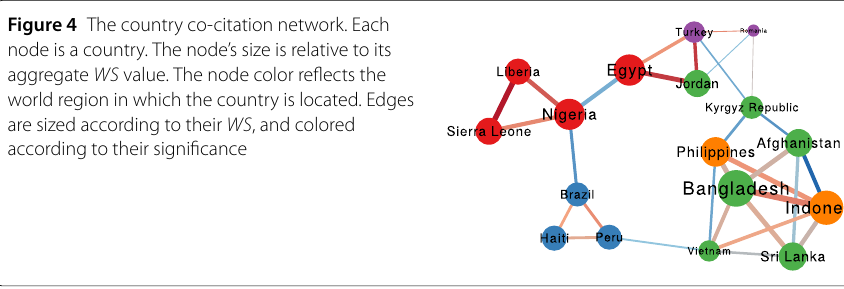
Figure 4 The country co-citation network. Each node is a country. The node’s size is relative to its aggregate WS value. The node color reflects the world region in which the country is located. Edges are sized according to their WS , and colored according to their